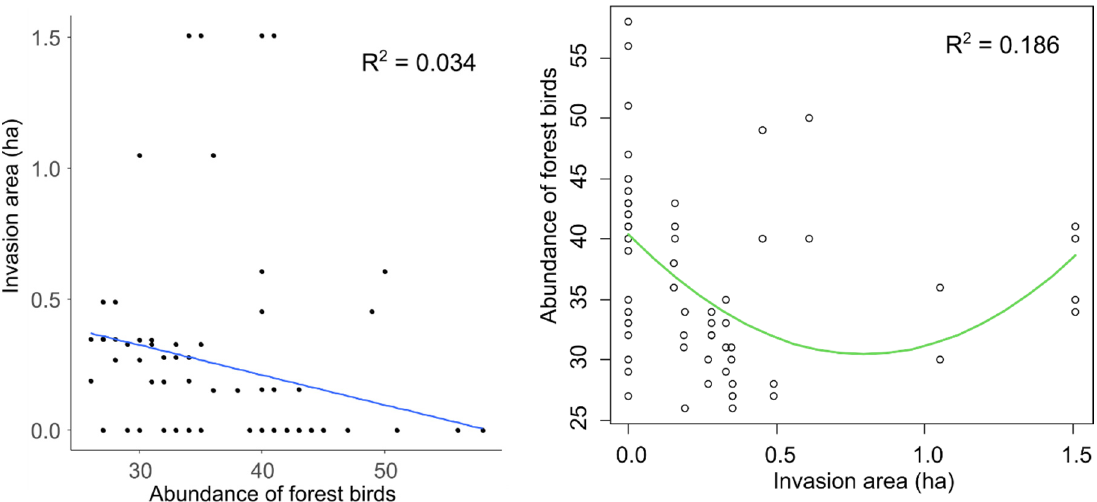
Figure A1. Plots showing the relationships between habitat variables used as predictors in the main LMM (Table 1) and the abundance of forest birds; the values of R-squared showed that in all cases the non-linear options better explained the relationships and reflected positive estimates in LMM.